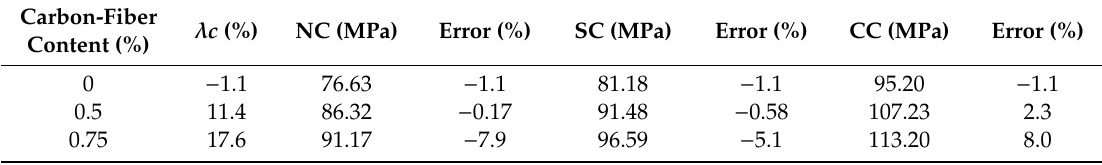
Table 9. Calculation of compressive strength of carbon-fiber RPC at 28 days.